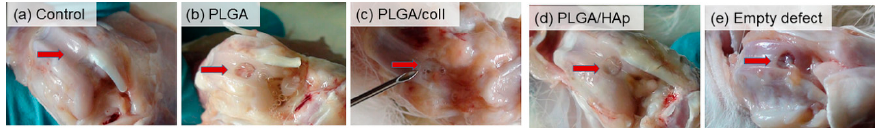
according to t -test, p < 0.05. contact angle, strength, and modulus E in compression test.